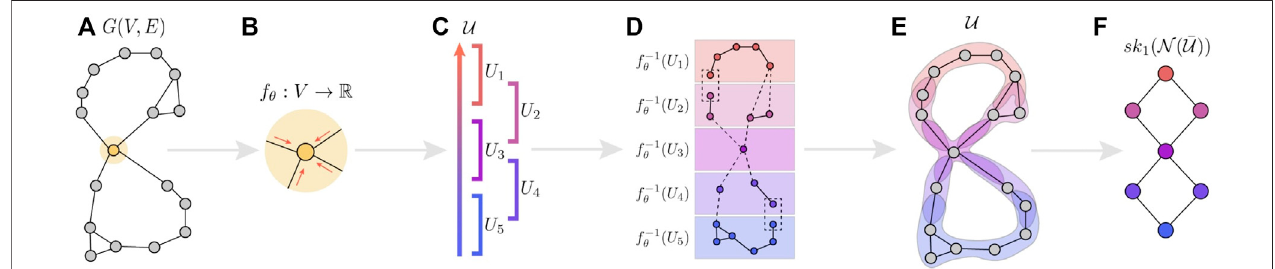
FIGURE 1 | A cartoon illustration of Structural Deep Graph Mapper (SDGM) where, for simplicity, a graph neural network (GNN) approximates a “ height ” function over the nodes in the plane of the diagram. The input graph (A) is passed through the GNN, which maps the vertices of the graph to a real number (the height) (B – C) . Given a cover U of the image of the GNN (C) , the edge-re fi ned pull back cover U is computed (D – E) . The dotted edges in (D) illustrate connections between the node clusters (strucutal connections), while the dotted boxes show nodes that appear in multiple clusters (semantic connections). The 1-skeleton of the nerve of the edge-re fi ned pull back cover provides the pooled graph (F)